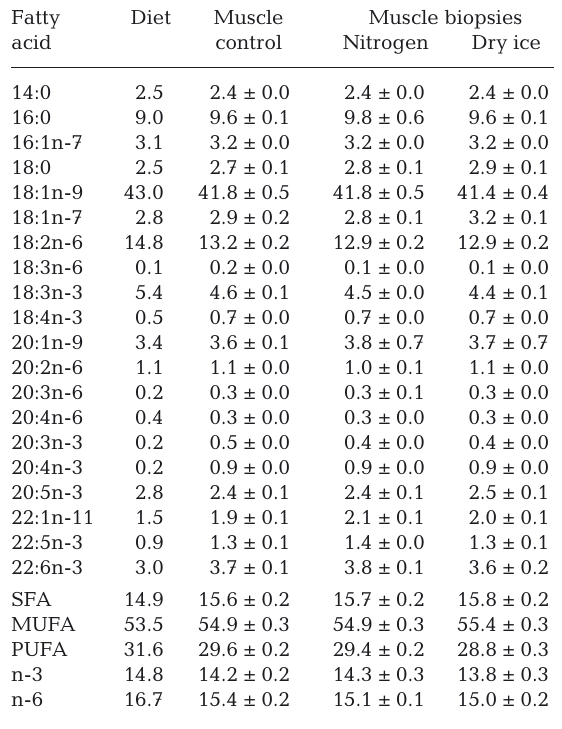
Table 4. Salmo salar . Triacylglycerol fatty acid composition (percent of fatty acids) of diet, control muscle and muscle biopsies (in liquid nitrogen or dry ice) of farmed sexually mature Atlantic salmon. Data are means (±SEM) of 12 fish. Potential differences between the tissues were assessed by 1-way ANOVA and Tukey’s post hoc test. Significance was accepted at p < 0.05. There were no significant differences between the sampling methods. Muscle control: large white muscle fraction flash-frozen in liquid nitrogen to serve as control to the biopsies; muscle biopsies: small samples stored immediately after sampling in liquid nitrogen or on dry ice; SFA: saturated fatty acids; MUFA: monounsaturated